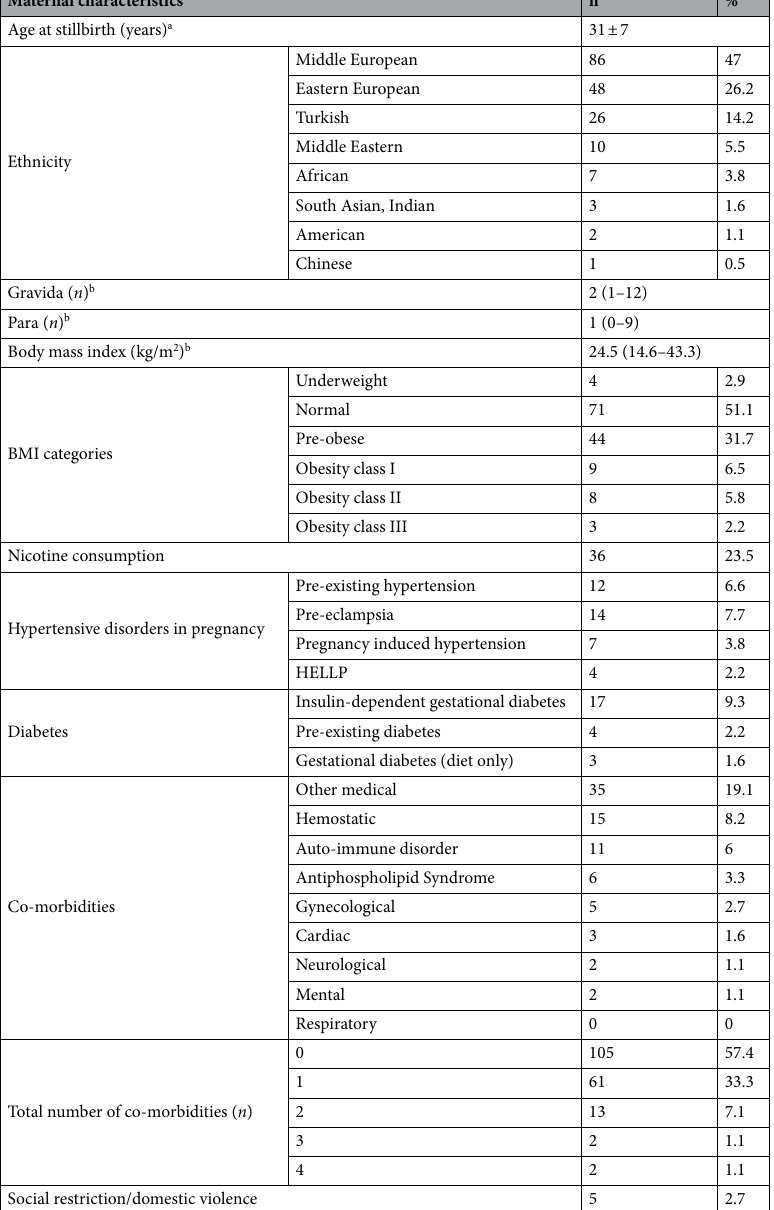
Table 1. Study sample characteristics (n = 183) after hospital admission for stillbirth delivery at the Department of Obstetrics and Gynecology, Medical University of Vienna between 2003 and 2019. BMI body mass index, HELLP hemolysis, elevated liver enzymes, low platelets. a Mean ± standard deviation. b Median (minimum –